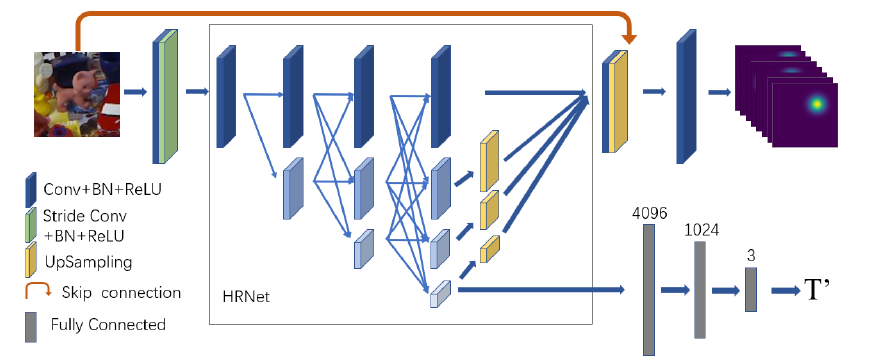
Figure 4. Multi-task network. We extend the heatmap regression structure to output both heatmaps and